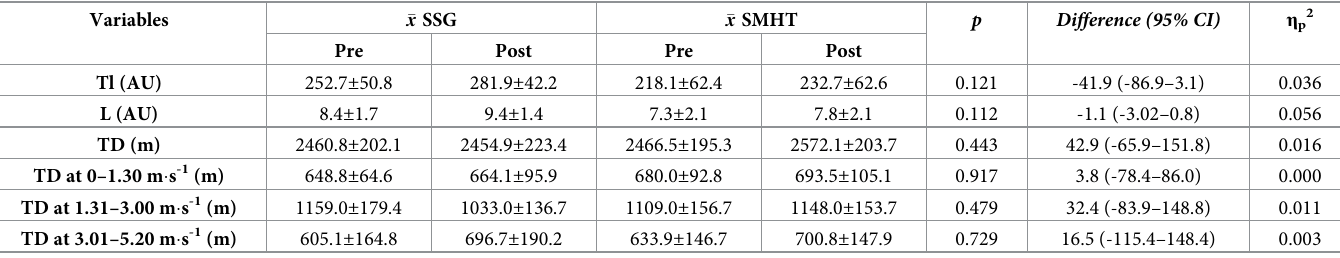
Table 3. Effect of SSG and SMHT training methods on game motion characteristics of the participants.